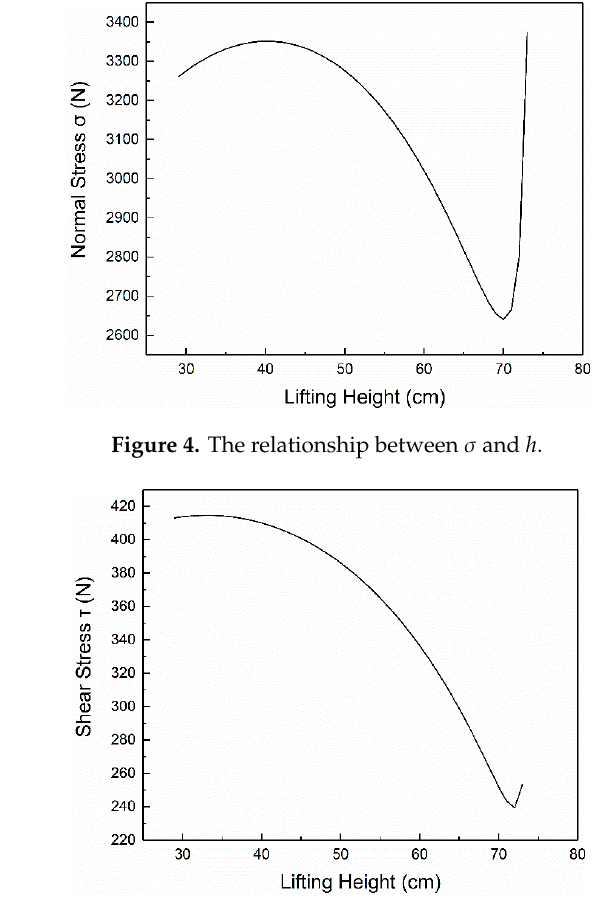
Figure 5. The relationship between τ and h .